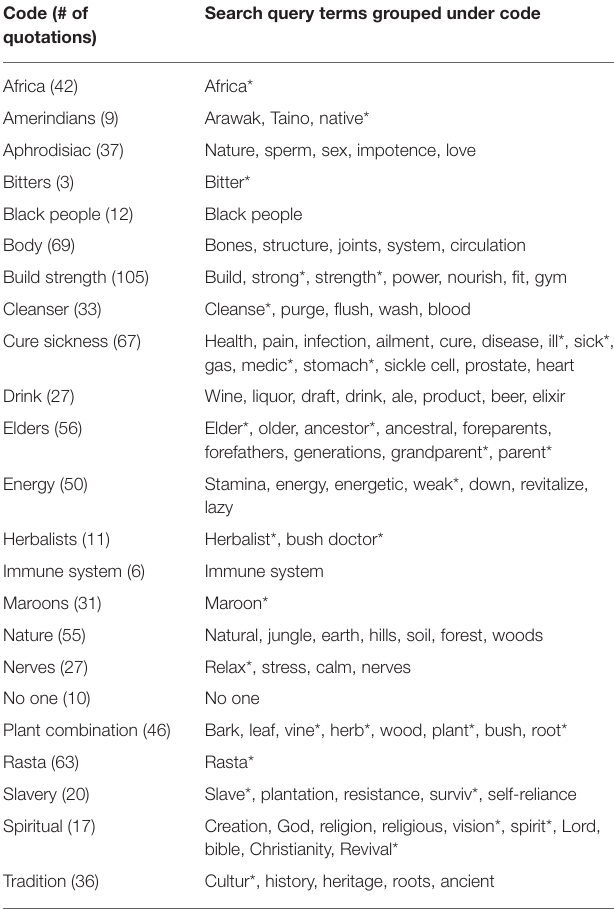
TABLE 1 | After reading multiple times through the interviews, search query terms were identified based on their recurrence, and subsequently used to conduct additional searches to cover all